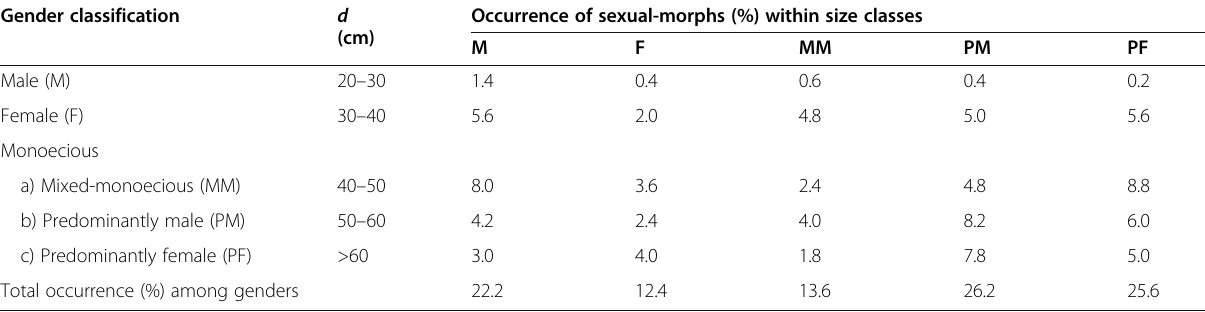
Table 2 Occurrence of sexual-morphs (in percentage) within size classes and among genders in Cedrus deodara populations ( d : diameter, n = 500)